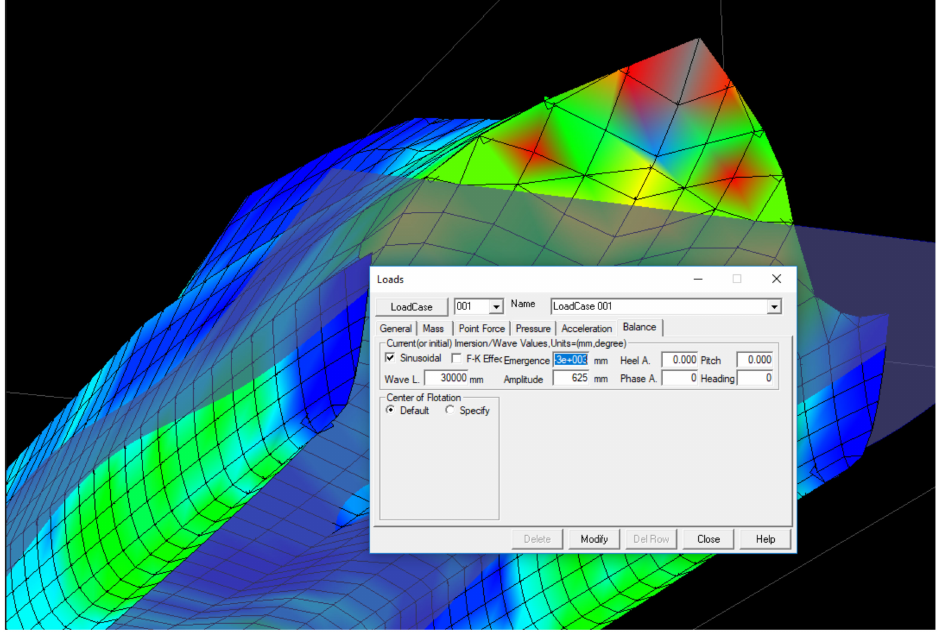
Figure 16. Total of a 1.0 g vertical acceleration applied to FE model and stress